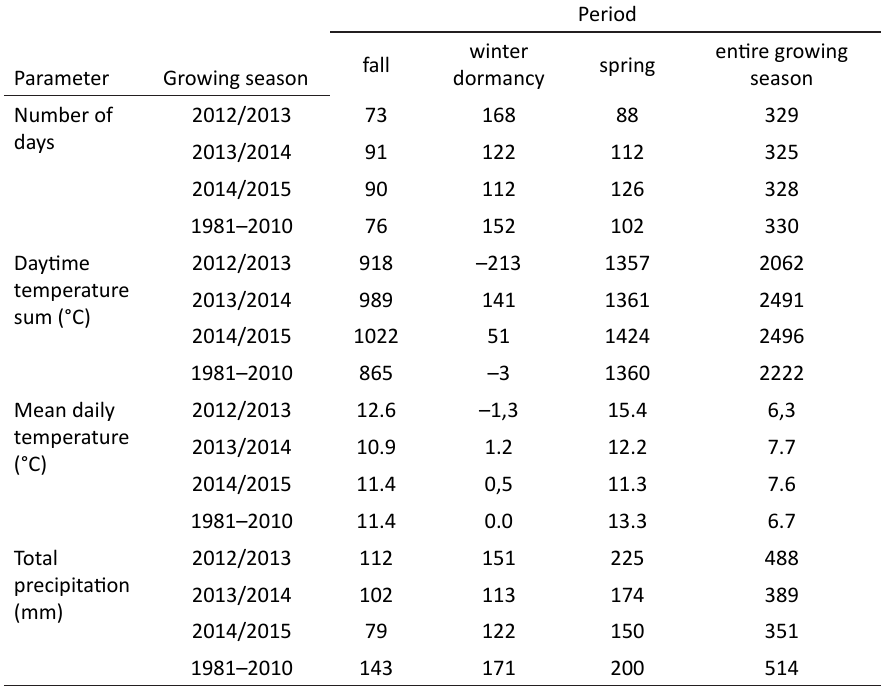
Table 1. Phenological development of winter oilseed rape, weather conditions in 2012–2015 and